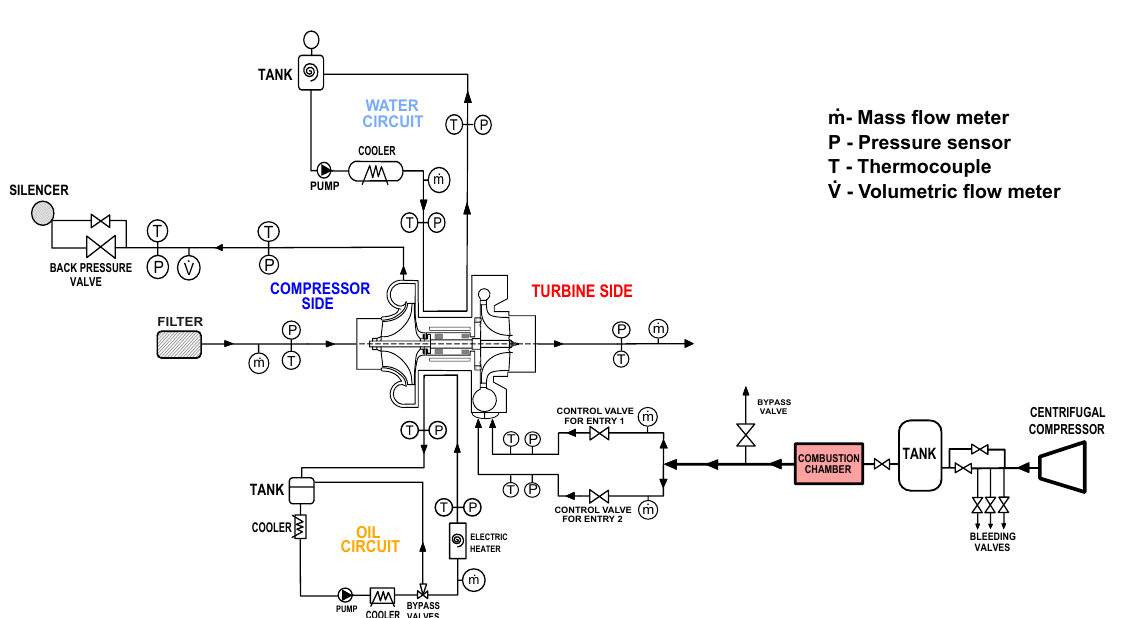
Figure 2. Schematic layout of a turbocharger gas stand for testing the double entry turbine. The locations of the main sensors are also shown.